Question: In one sentence, what is this figure communicating?
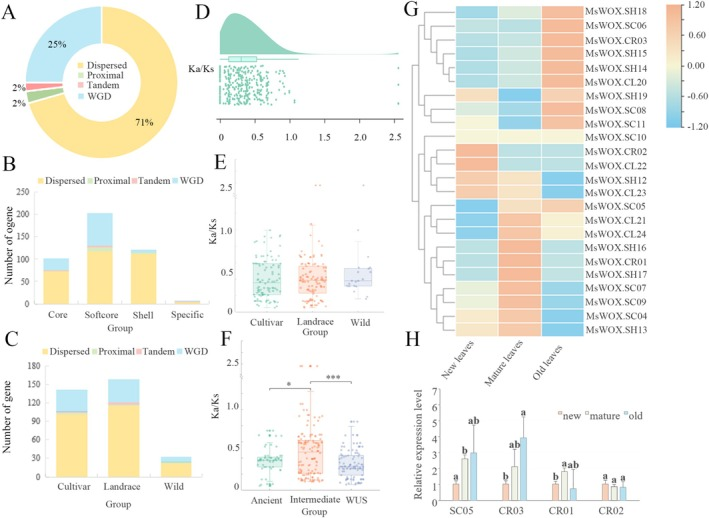
Answer: (A) Percentage of genes in each copy type; (B) Number of genes of different copy types in each OGG; (C) Number of genes of different copy types within each type; (D) Ka/Ks distribution of alfalfa WOX gene family members; (E) Ka/Ks variation of WOX genes across different domestication types; (F) Ka/Ks variation of WOX genes in each clade (* p < 0.05; *** p < 0.001); (G) Expression levels of representative OGG genes during leaf development; (H) Expression patterns of four representative genes in leaves at different developmental stages, including young, mature, and old leaves.